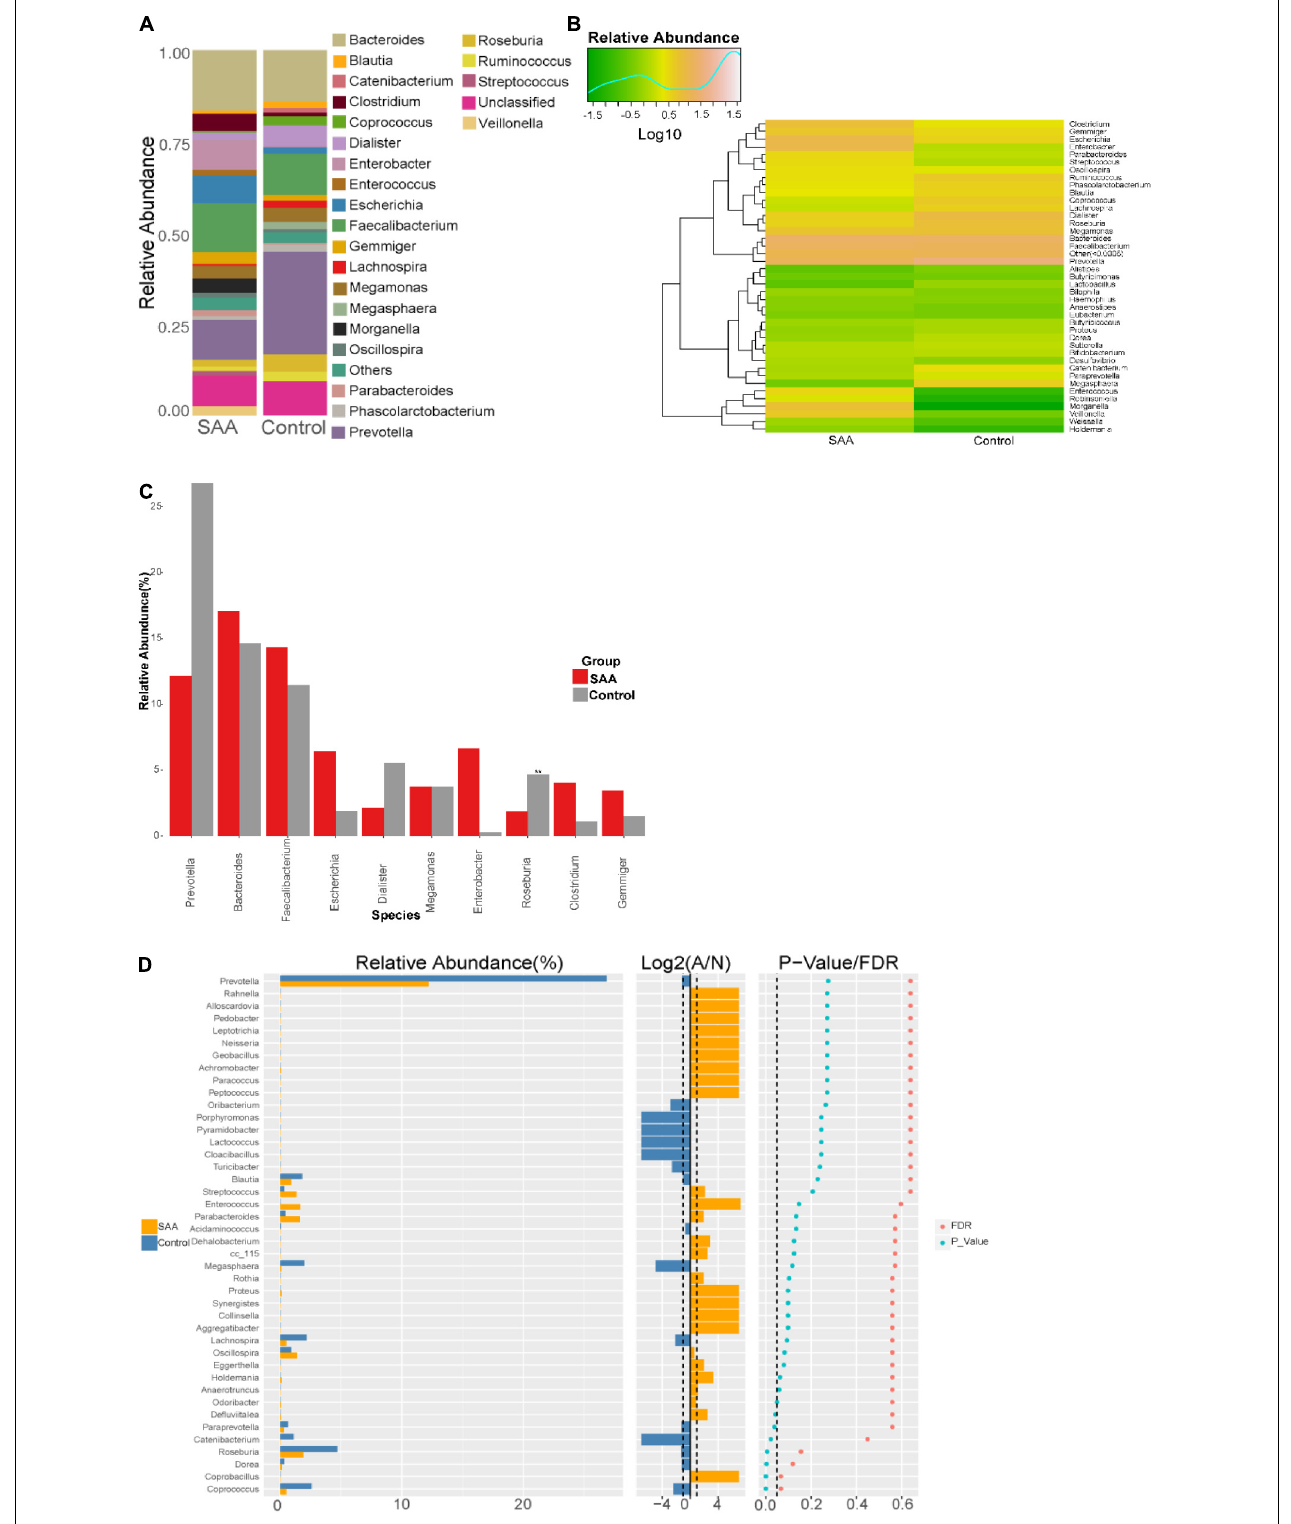
FIGURE 7 | Intestinal microbial compositions of the SAA and control groups at the genus level. (A) Bar plot, (B) heatmap, (C) top 10 most abundant species, (D) Wilcoxon rank-sum test results.